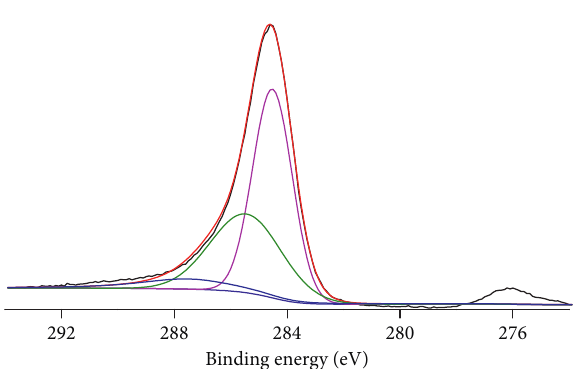
Figure 2: C1s peaks for Coal 2.